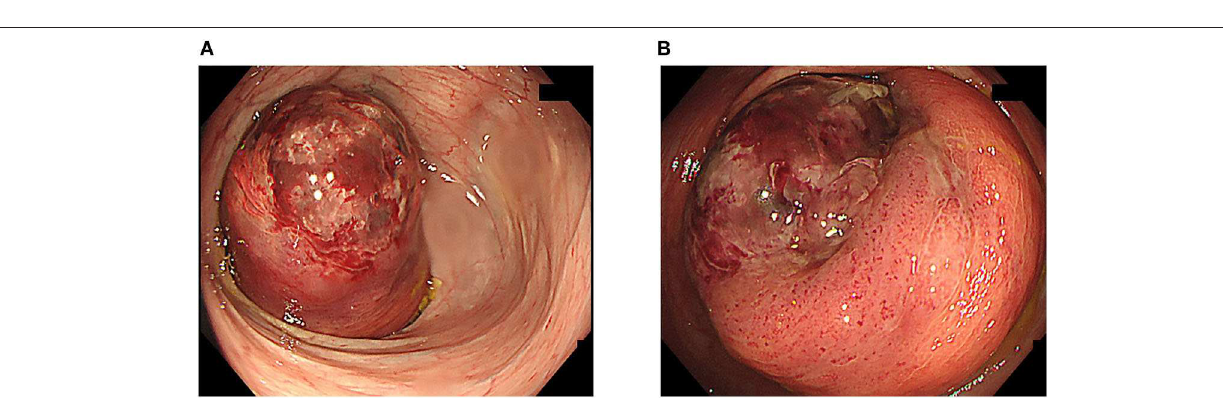
FIGURE 2 | Total colonoscopy. (A) Total colonoscopy showed intussusception of the intestine with an ulcer at the top at the transverse colon. (B) The tip of the intussusception was red and had formed an ulcer. case was intussusception at a young age (9 years), with no lead point, which occurred at the tip of the cecum. In addition, we were able to observe intussusception on